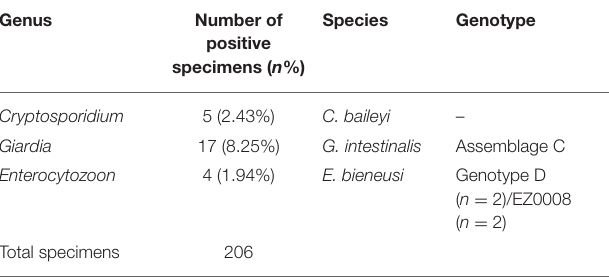
TABLE 1 | Occurrence of Cryptosporidium , Giardia, and microsporidia. Genus